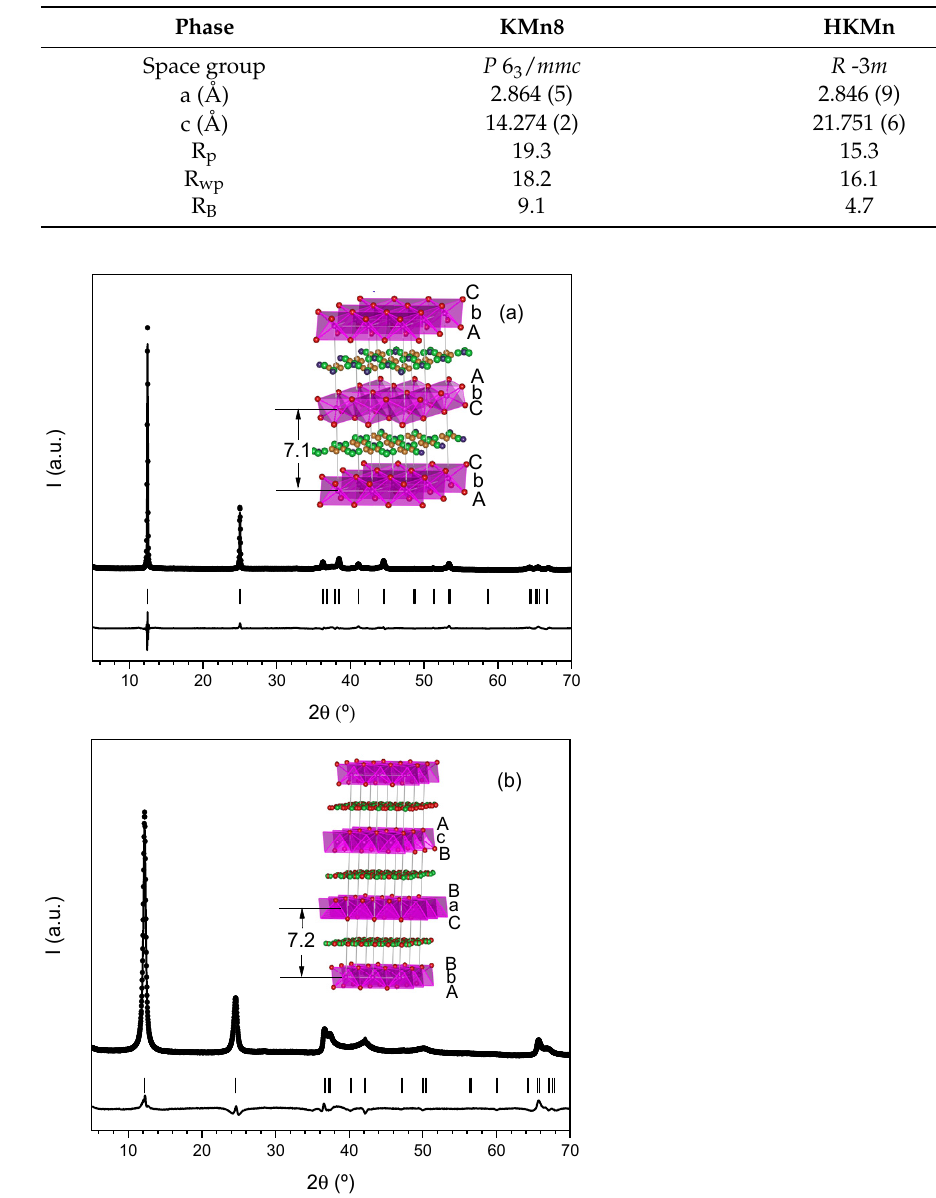
Table 1. Crystallographic data of KMn8 and HKMn.